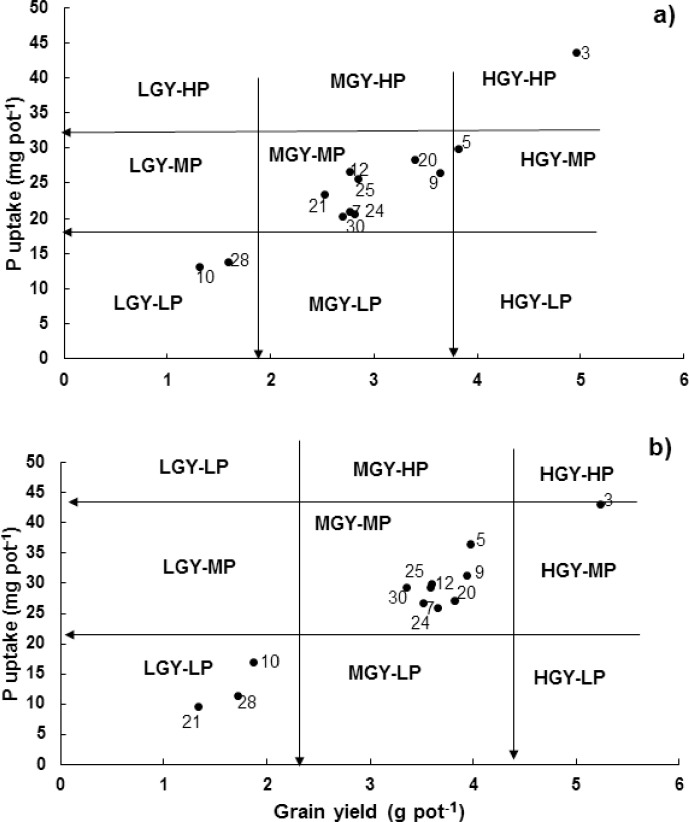
Classification of wheat genotypes at vegetative growth stage (in pot culture) for P utilization efficiency a) at deficit P and b) at adequate P supply. Data are the mean value of four replicates. This categorization divides genotypes into nine categories i.e. low grain yield-low P (LGY-LP), low grain yield-medium P (LGY-MD), low grain yield-high P (LGY-HP), medium grain yield-low P (MGY-LP), medium grain yield-medium P (MGY-MP), medium grain yield-high P (MGY-HP), high grain yield-low P (HGY-LP), high grain yield-medium P (HGY-MP) and high grain yield-high P (HGY-HP) [30].